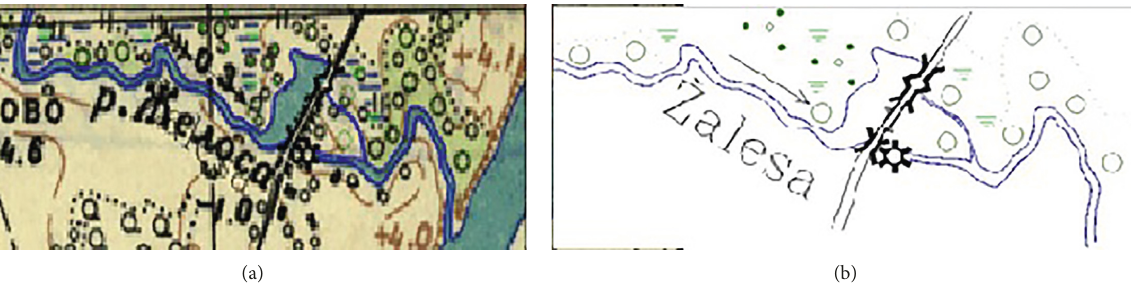
Figure 5: Digitized section of River ˇZalesa is represented in the topographic map of 1950 (source: http://www.geoportal.lt and authors’